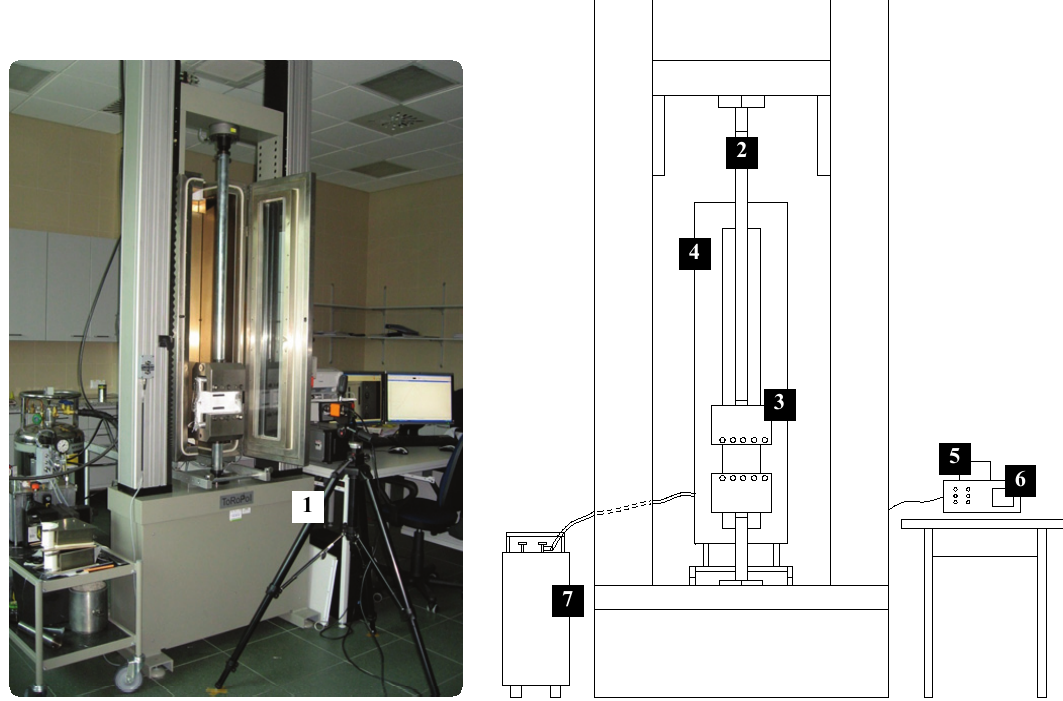
Fig. 1. Laboratory equipment for tensile